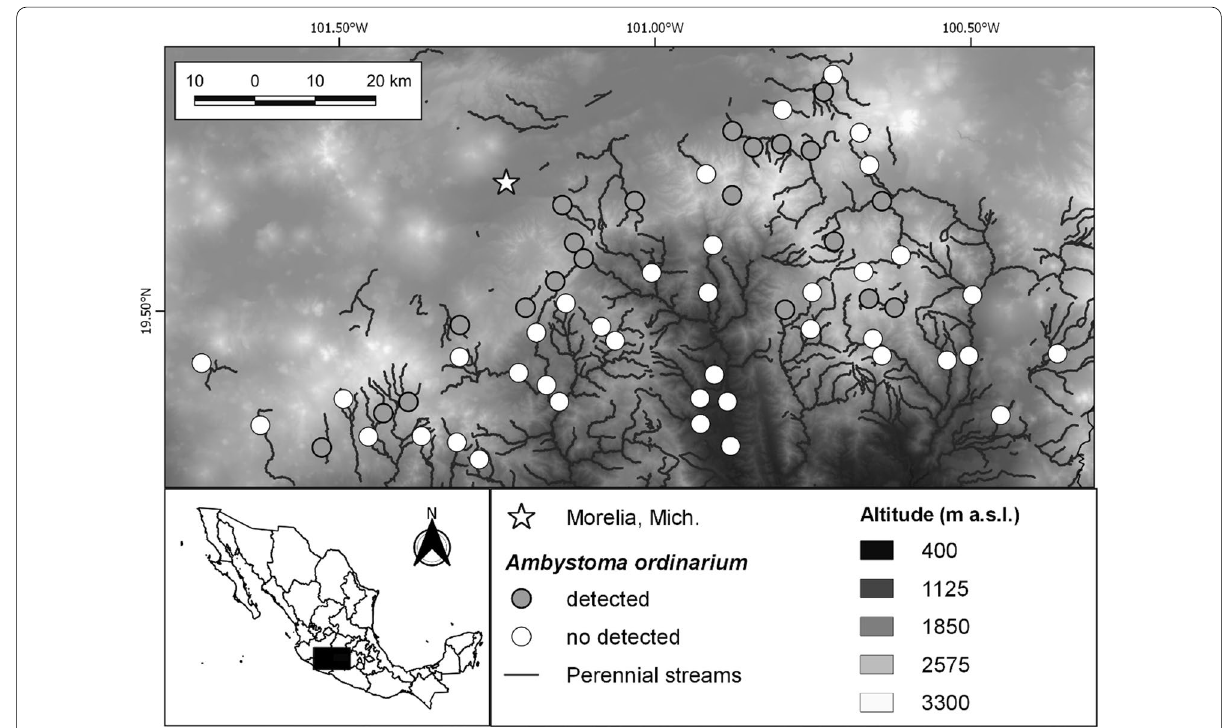
Fig. 1 Study region in Northwest Michoacán, Mexico. Each sampling unit, its altitude, and the detection of A. ordinarium are